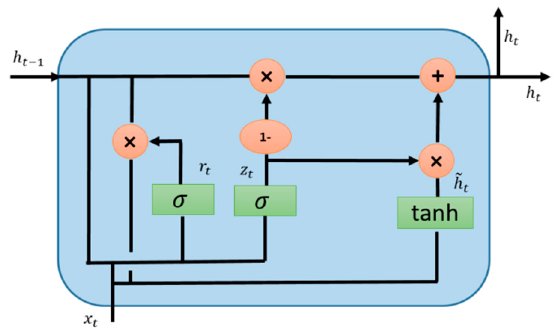
Figure 31. Diagram for Gated Recurrent Unit (GRU).